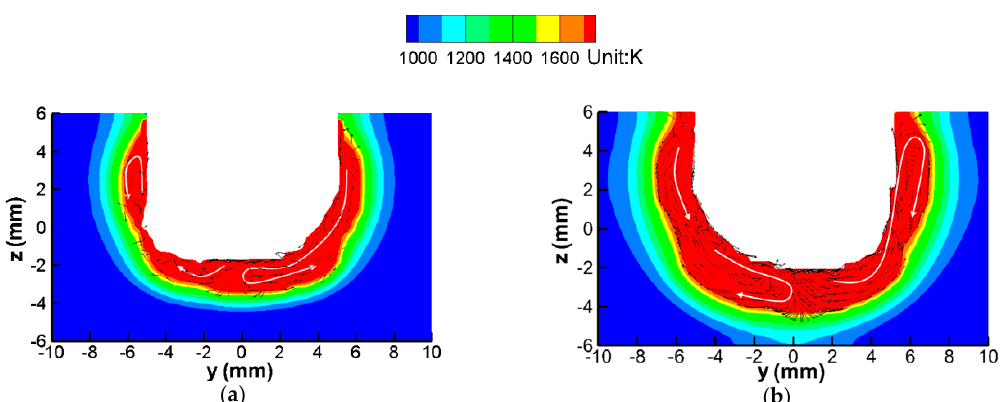
Figure 9. Fluid flow of the molten pool on cross section: ( a ) t = 0.35 s; ( b ) t = 0.62 s.